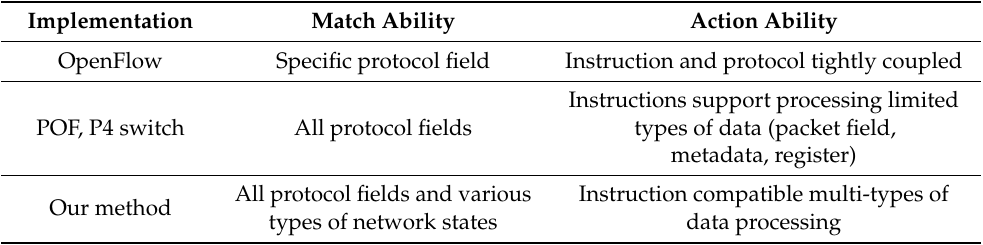
Table 2. Matching action model implementations.